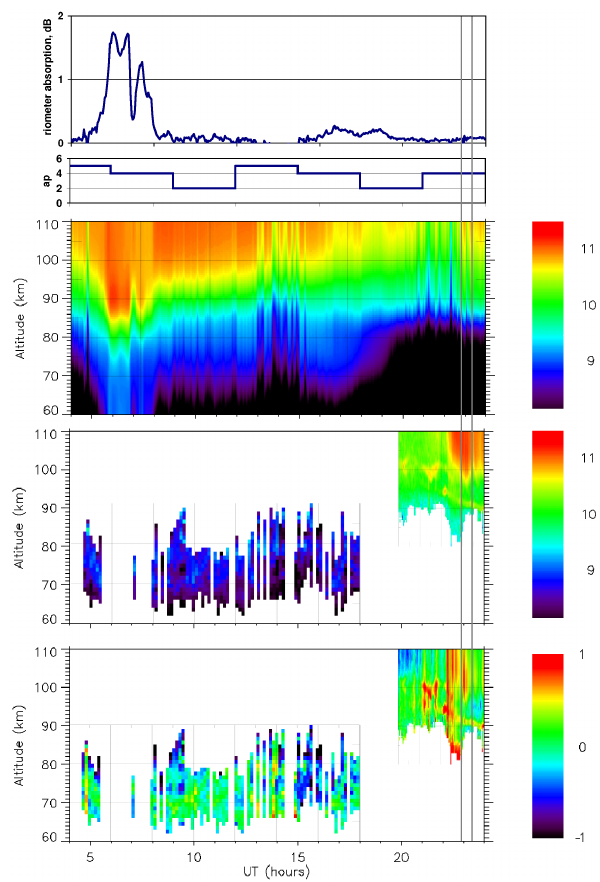
Fig. 4. Ionospheric conditions preceding the flights of MASS-1 and ECOMA-3 (grey vertical lines). The panels from the top are: Riometer absorption, magnetic index, electron density prediction according to the IMAZ model, electron densities from the MF radar (until 18:0UT) and according to EISCAT UHF (20:00 to 24:00UT), and the ratio between measurements and the IMAZ prediction. The electron desities are logarithmically colour coded in m − 3 and the ratio in the bottom panel is on a logarithmic scale from 0.1 to